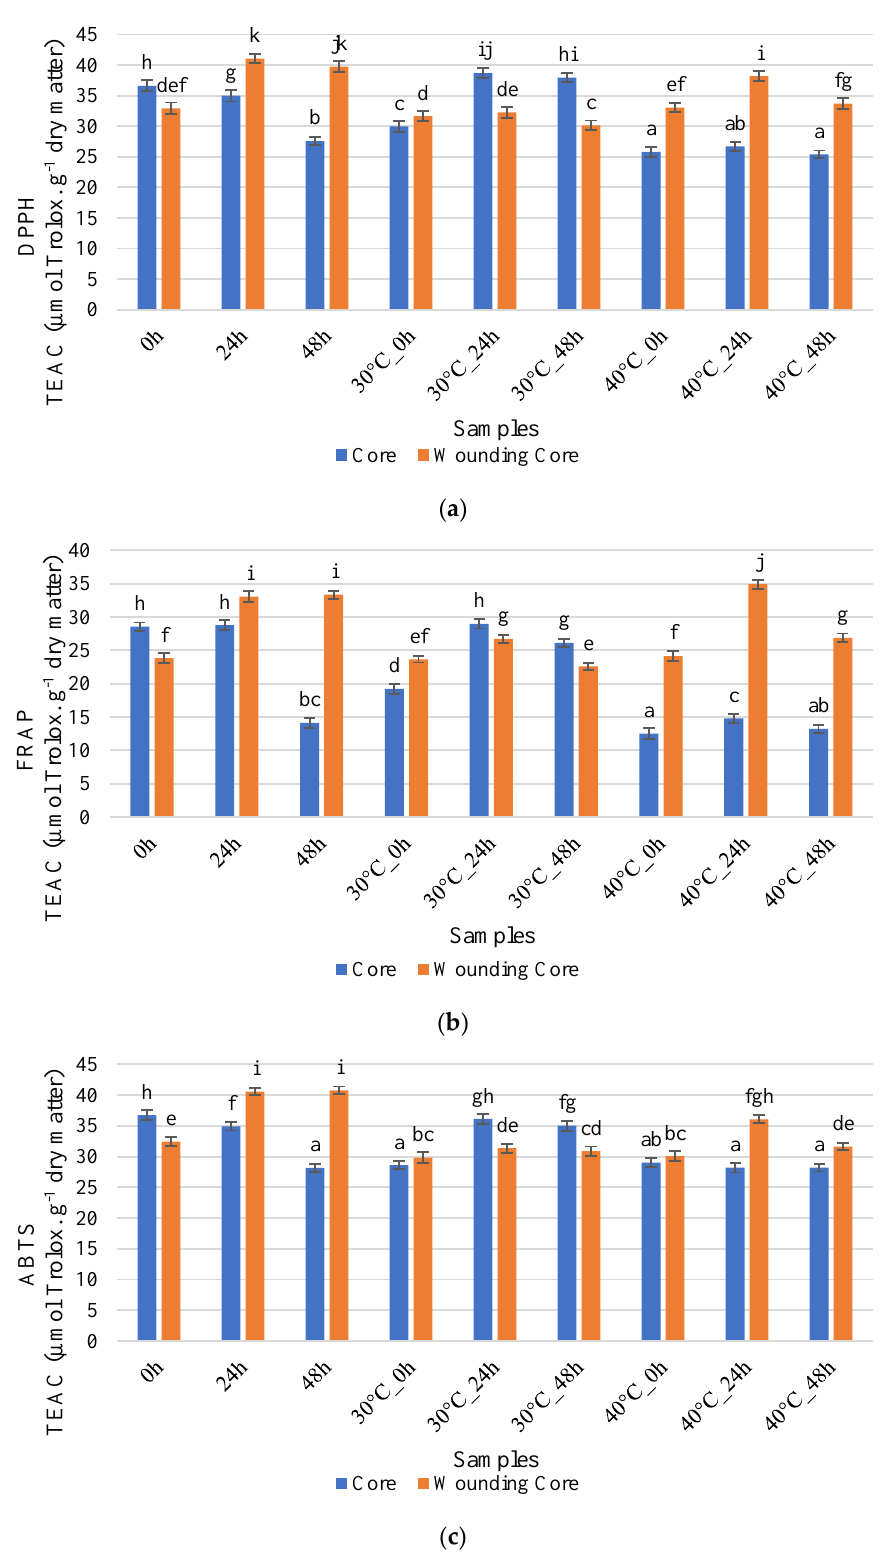
Figure 4. Effect of abiotic stresses, heat treatment and wounding, on antioxidant activity of pineapple core: ( a ) DPPH (2,2-diphenyl-1-picrylhydrazyl); ( b ) FRAP (Ferric Reducing Antioxidant Power); and ( c ) ABTS (2,2 ′ -azino-bis (3-ethylbenzothiazoline-6-sulphonic acid)). Error bars stand for ± standard deviation ( n = 9). Different letters express significant differences between samples.